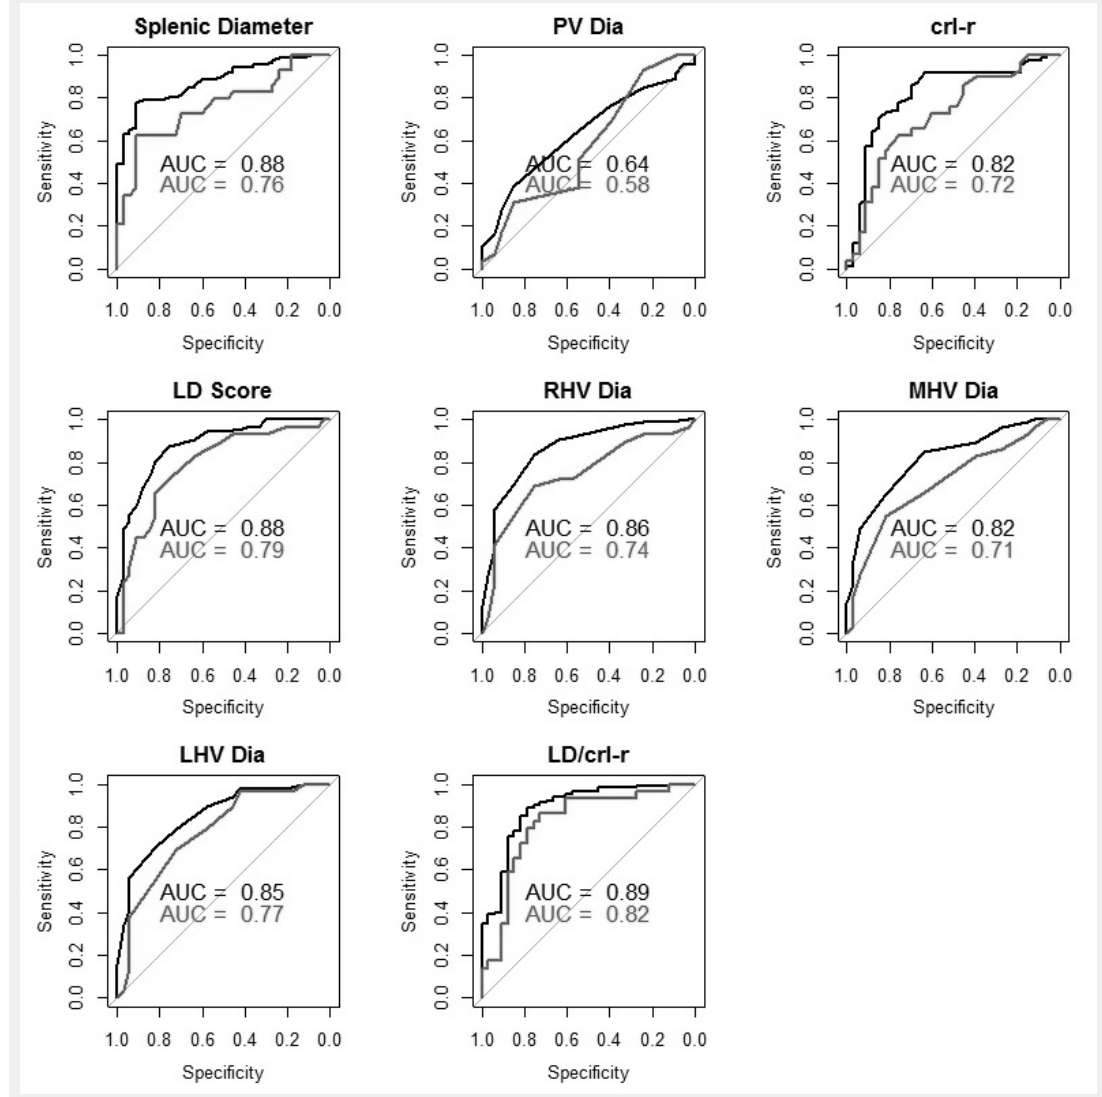
Figure 4 Receiver operating characteristic curves of the cirrhosis group (black) and the fibrosis group (gray) demonstrated highest AUC for ld/crl-r. AUC = area under the curve; spl dia = splenic diameter; pv dia = portal vein diameter; crl-r = caudate-right lobe ratio; ld score = sum of liver veins diameter; rhv dia, mhv dia, lhv dia = right, middle and left hepatic vein diameters; ld/crl-r = ld score divided by